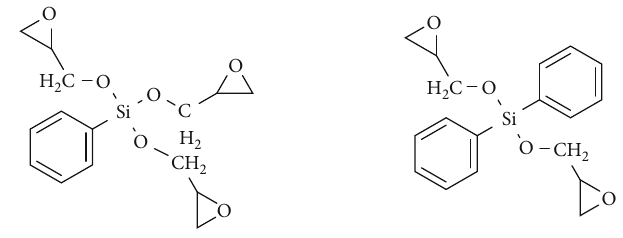
Figure 2: Silicon-fabricated epoxy resin